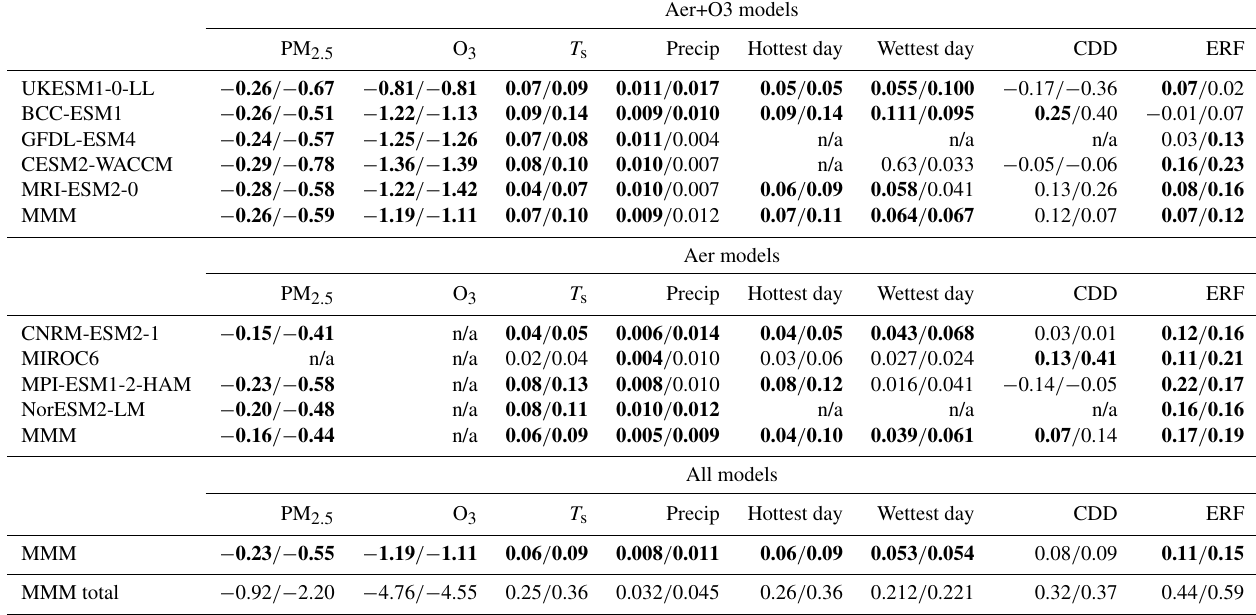
Table 1. Air pollution and climate responses to NTCF mitigation. Annual mean 2015–2055 trends in surface particulate matter (PM 2 . 5 ), ozone (O 3 ), surface temperature ( T s ), precipitation (Precip), hottest day, wettest day, CDDs, and the effective radiative forcing (ERF) for NTCF mitigation. First set of numbers is the global mean trend; second set of numbers is the land-only trend. Trends significant at the 95% confidence level are denoted by bold font based on a t test. Trend units are Kdecade − 1 for T s and hottest day; mmd − 1 decade − 1 for Precip and wettest day;µgm − 3 decade − 1 for PM 2 . 5 ; ppbdecade − 1 for O 3 ; days per yeardecade − 1 for CDDs; and Wm − 2 decade − 1 for ERF. The first five models include both aerosol and ozone changes (Aer+O3 models); bottom four models include only aerosol changes (Aer models). MMM is the multi-model mean and the last row (“MMM total”) shows the total change over the entire 2015–2055 time period based on all models. n/a indicates not applicable.